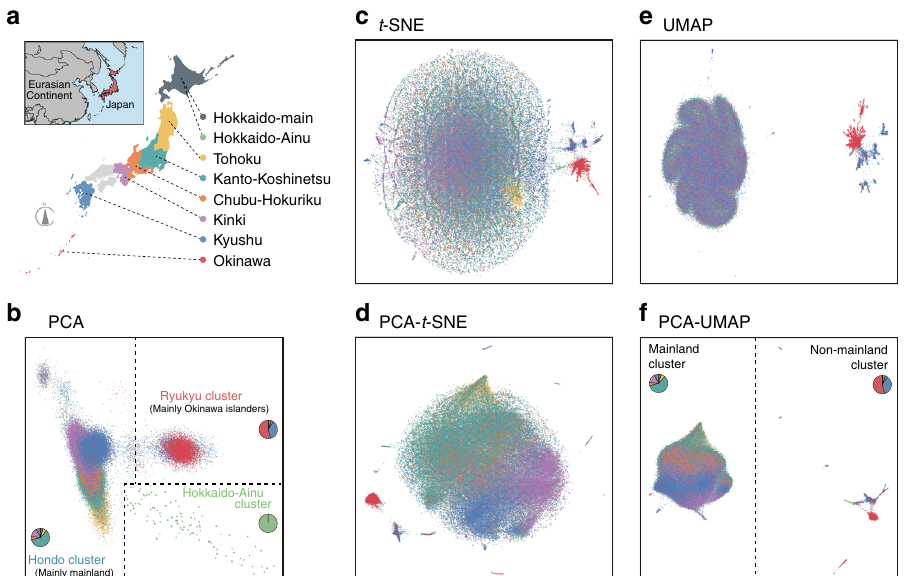
Fig. 2 Dimensionality reduction of biobank-scale genotype data from the Japanese population. Two-dimensional illustrations of biobank-scale genotype data from the Japanese population by the fi ve dimensionality reduction methods. The color of individual points indicates the region where a given study individual was recruited. a Geographic description of the Japanese islands and the de fi nitions of the regions and colors. b The fi rst two principal components from PCA. Individuals in Hondo (mainly in the mainland), in Ryukyu (mainly in Okinawa and surrounding islands), and in Hokkaido-Ainu (indigenous population in Hokkaido) were de fi ned as described previously. c – e Two-dimensional illustrations by c t -SNE, d PCA- t -SNE, e UMAP, and f PCA – UMAP. Individuals in the mainland and non-mainland clusters were de fi ned based on the PCA – UMAP results. The pie charts depicted in b , f represent the constitutions of individuals, who were marked according to the recruitment regions in corresponding